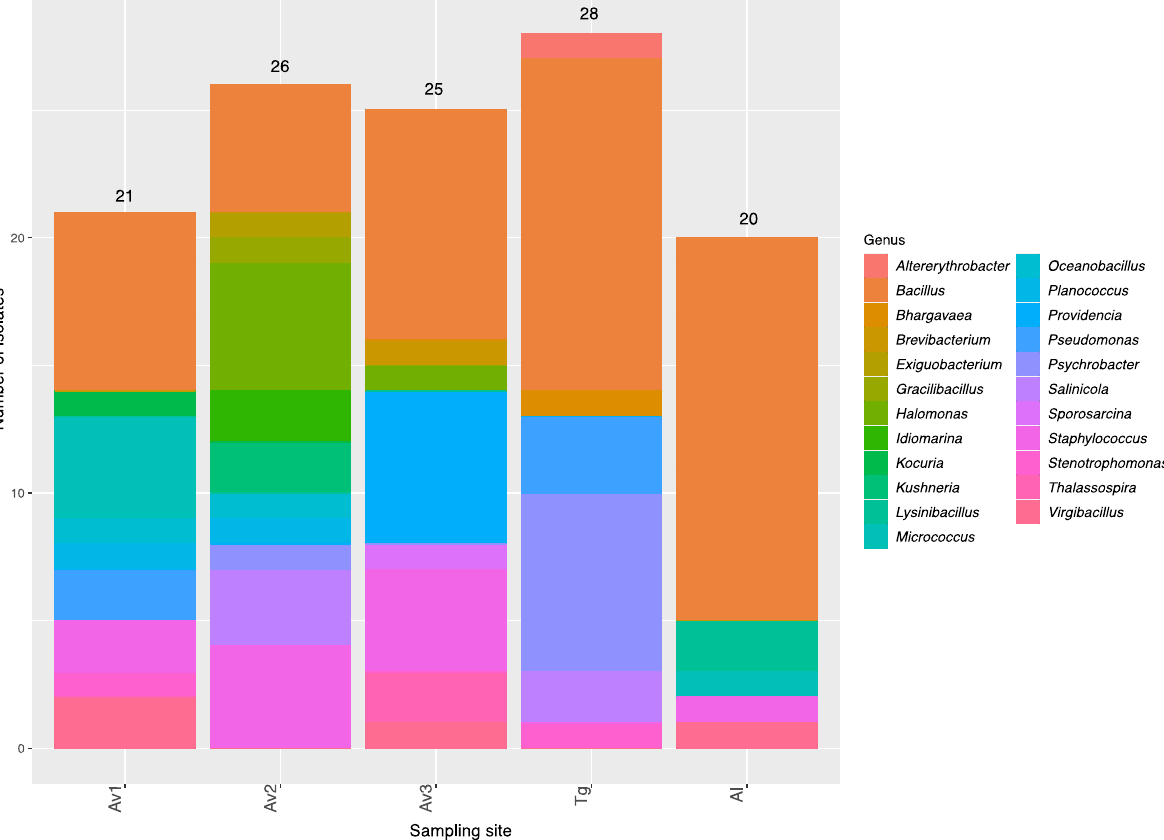
Figure 1. Distribution by genera of the 120 bacterial isolates retrieved from the rhizosphere and root endosphere of Salicornia ramosissima , in the subsets corresponding to 5 sampling sites: Av1, Av2, Av3––Ria de Aveiro; Tg––Tagus estuary; Al––Almargem (Algarve).